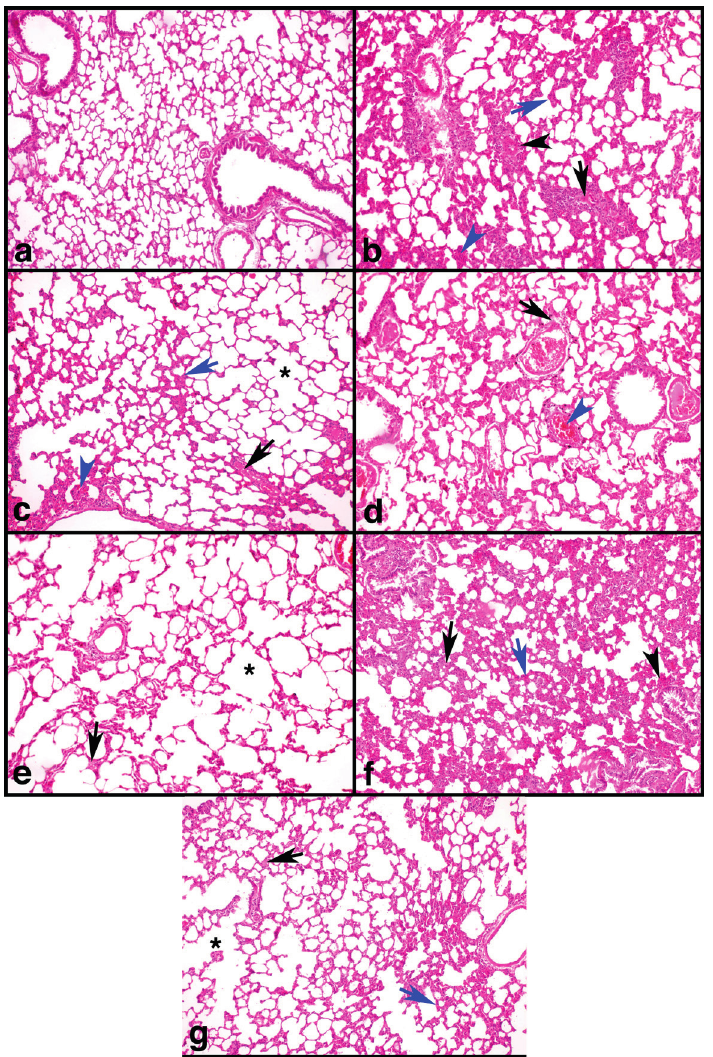
Figure 3 - a-g: Effects of Aliskiren treatments on light micrographs in rats’ lung tissues. a) SHAM group animal lung section showed normal histologic features. Haematoxylin and eosin staining. Magnification, 100X. b) CAR group animal lung section has severe edema (black arrow), Perivascular /Peribronchiolar inflammation (black arrow head), thickness in interalveolar septum and inflammatory cell infiltration (blue arrow) and vascular congestion (blue arrow head). Haematoxylin and eosin staining. Magnification, 100X. c) CAR+DeXA group animal lung section showed mild emphysema (asterisk), moderate edema (black arrow), mild thickness in interalveolar septum and inflammatory cell infiltration (blue arrow) and mild vascular congestion (blue arrow head). Haematoxylin and eosin staining. Magnification, 100X. d) CAR+INDO group animal lung section showed moderate edema (black arrow), mild thickness in interalveolar septum and inflammatory cell infiltration (blue arrow) and mild vascular congestion (blue arrow head). Haematoxylin and eosin staining. Magnification, 100X. e) CAR+AlIS50 group animal lung section showed moderate edema (arrow), emphysema (asterisk), perivascular /peribronchiolar inflammation, thickness in interalveolar septum, vascular congestion, inflammatory cell infiltration. Haematoxylin and eosin staining. Magnification, 100X. f) CAR+AlIS100 group animal lung section showed moderate edema (black arrow), mild emphysema, severe perivascular /peribronchiolar inflammation (black arrow head) and thickness in interalveolar septum and inflammatory cell infiltration (blue arrow), vascular congestion. Haematoxylin and eosin staining. Magnification, 100X. g) CAR+AlIS200 group animal lung section showed mild edema (black arrow), moderate emphysema (asterisk), mild perivascular /peribronchiolar inflammation, thickness in interalveolar septum and inflammatory cell infiltration (blue arrow). Haematoxylin and eosin staining. Magnification, 100X. SHAM: Sham-operated, ALIS: Aliskiren 50-100-200 mg/kg, CAR: Carrageenan, INDO: Indomethacine, DEXA: